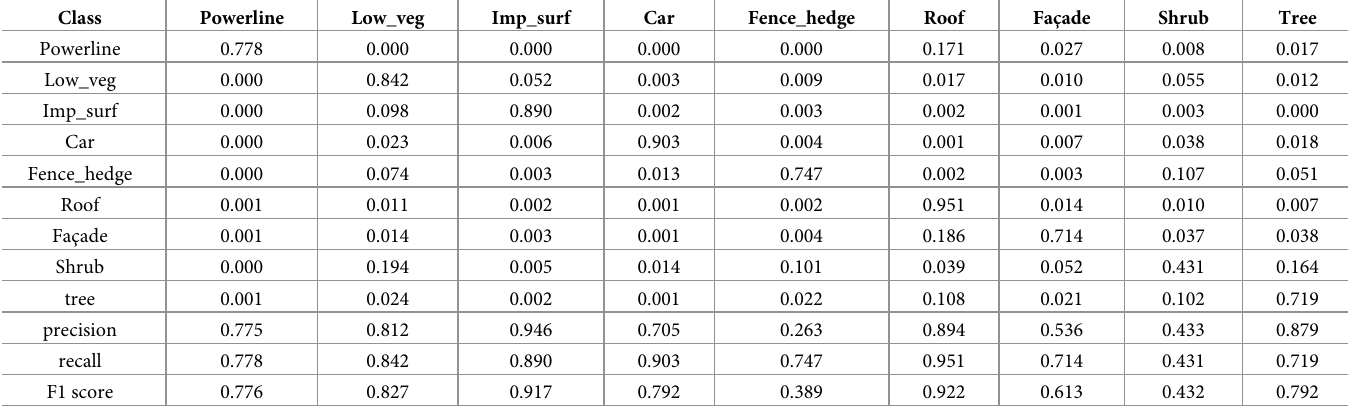
Table 5. Classification confusion matrix of our proposed method. The evaluation metrics about precision, recall and F1 score of each class are reported. The numbers in the confusion matrix are normalised along each